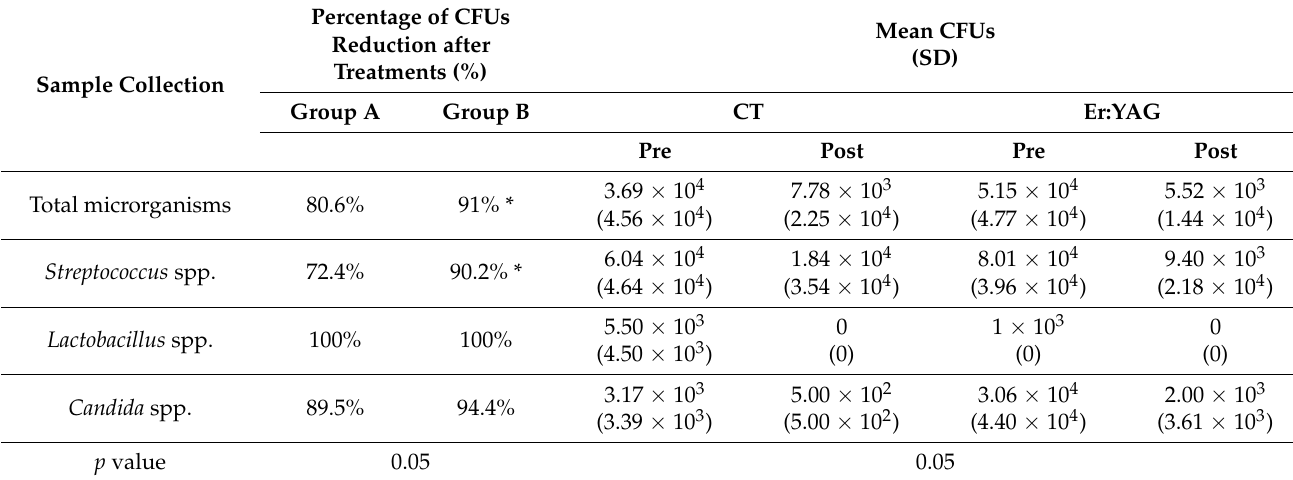
Table 2. This table report the percentages of colony-forming units (CFUs) reduction (%) and CFUs performed in triplicate Streptococcus (mean ± SD) for each micro-organisms macro-group considered for both the intervention group B (Er:YAG) and vs. the control group A (CT) samples. A comparison of the CFUs percentages of reduction and mean CFUs (SD) for post- and pre-treatment between group B (Er:YAG) and group A (CT) was performed for each of the four selected macro-groups of micro-organisms. * p < 0.05. The mean CFU was only performed in the culture media in which there was the growth of the genus under investigation.